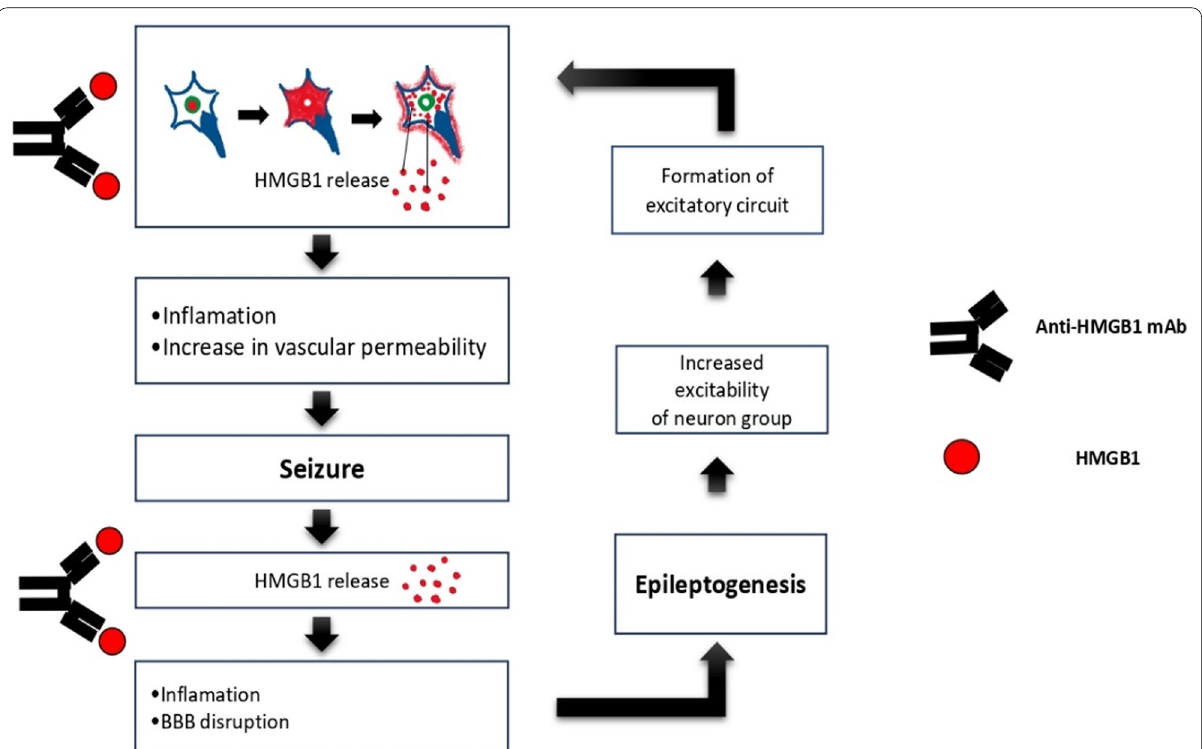
Fig. 2 Anti-HMGB1 mAb can inhibit status epilepticus and epileptogenesis. HMGB1; High Mobility Group Box 1, BBB; blood brain